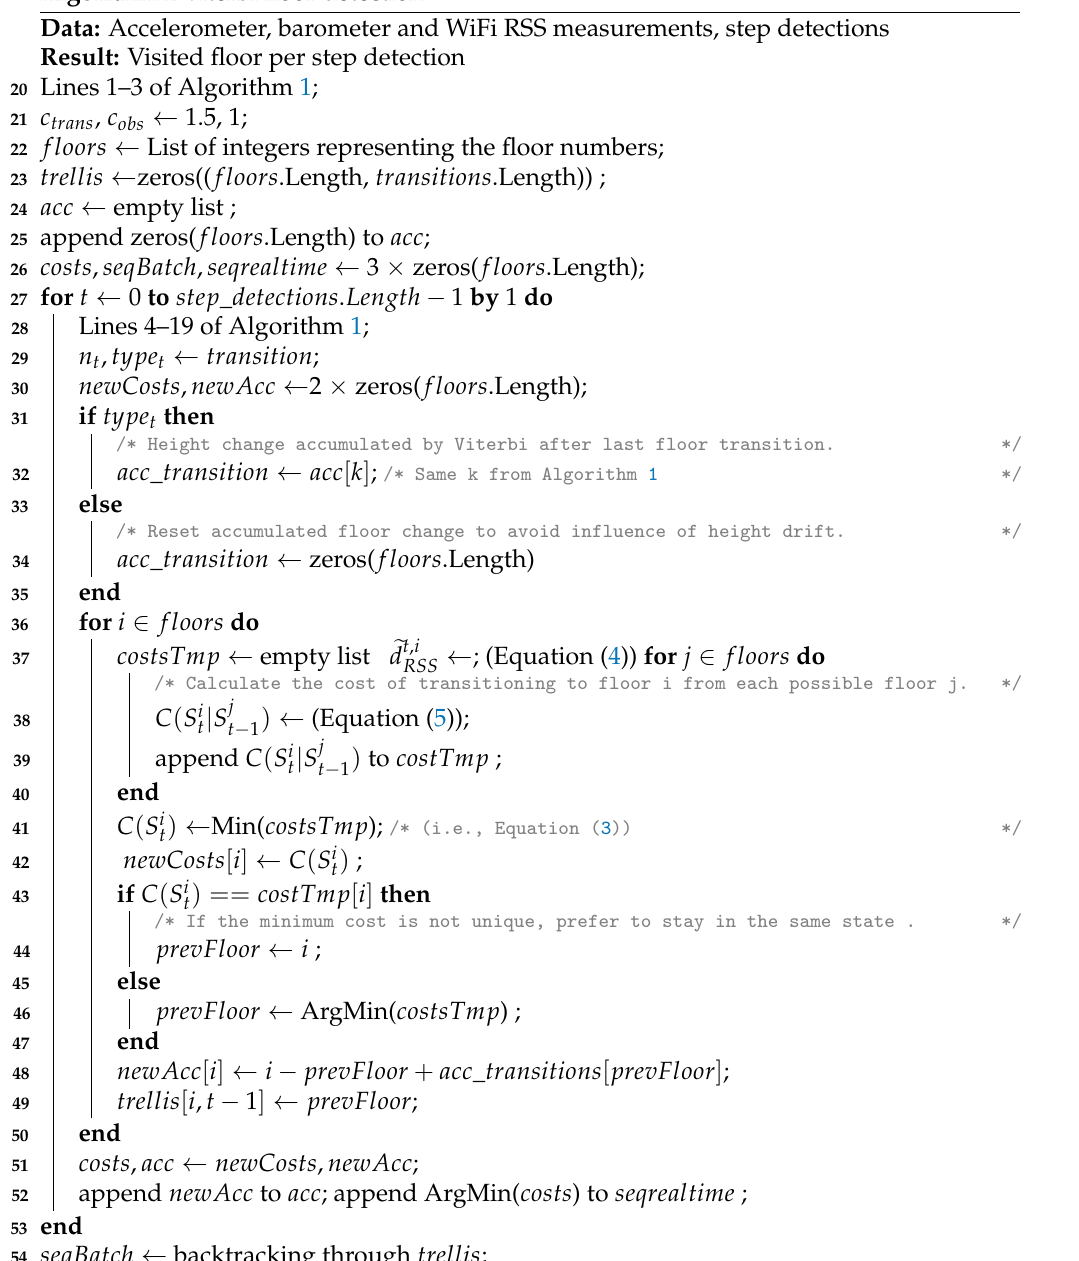
Algorithm 2 Viterbi floor detection. Data: Accelerometer, barometer and WiFi RSS measurements, step